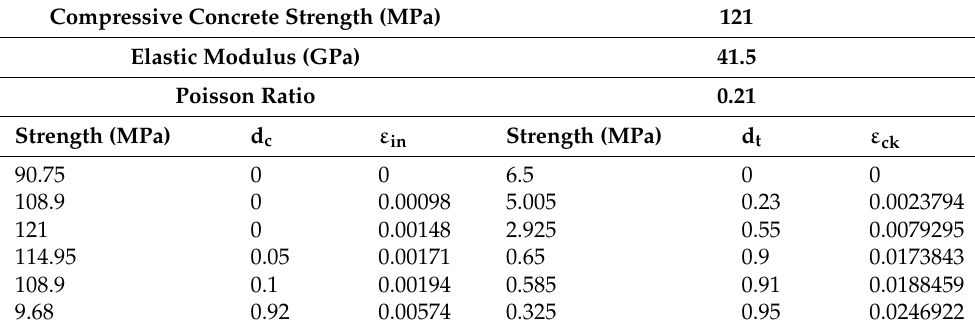
Table 9. Properties of UHPFRC along with CDP model parameters in compression and tension in the flexural test.